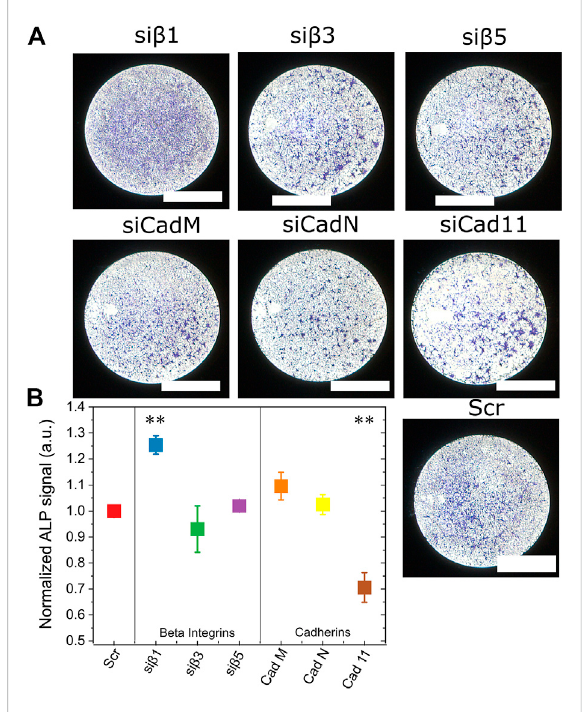
FIGURE 7 Roleof β chainintegrinsandcadherinsinALPexpression.ALP expressionwasquanti fi edaftersilencingofthethreemajor β chain integrins and cadherins (same conditions as in Figure 6) (A) Representative images of a single well of a 96-well plate are shown for each silencing condition. (B) Quanti fi cation of alkaline phosphatase activity (ALP) after 4 days of C2C12 cell culture (24H in GM and 72 H in DM) on fi lms with matrix-bound BMP-2,